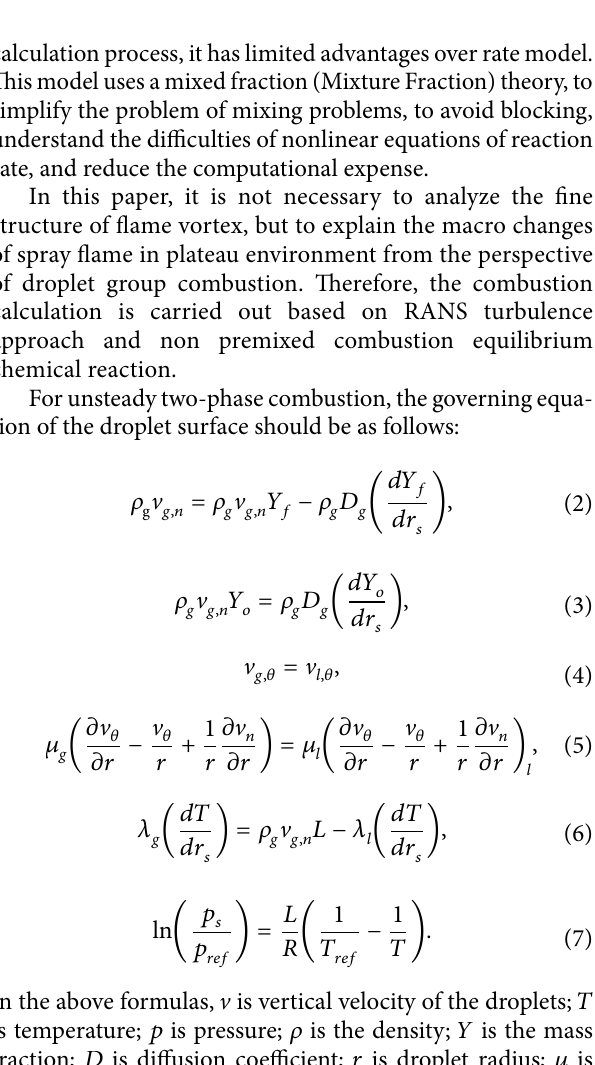
Experimental case